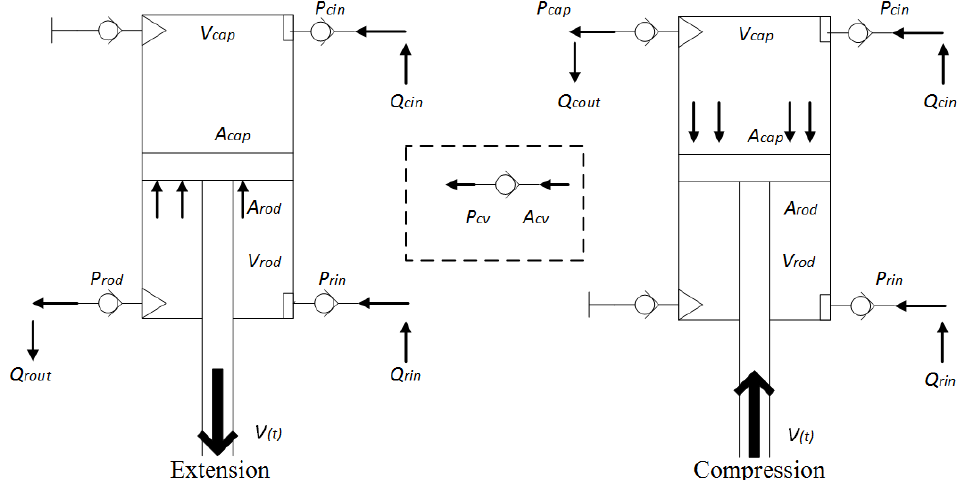
Figure 2. The schematic view of fluid flows in shock absorber body and hydraulic rectifier.